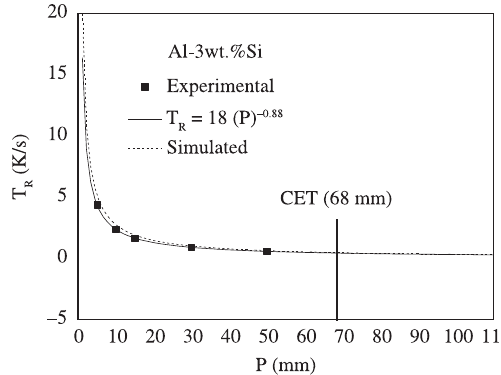
Figure 8. Tip cooling rate as a function of position from the metal-mold interface for the Al- 3wt.%Si alloy during horizontal solidification.